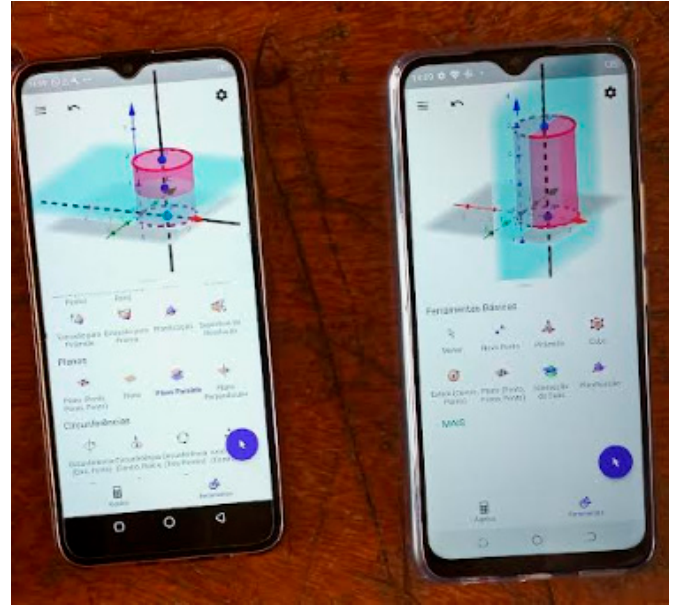
Figure 6. Secant plane not parallel to the surface axis and secant plane parallel to the surface axis represented in the dynamic software GeoGebra.